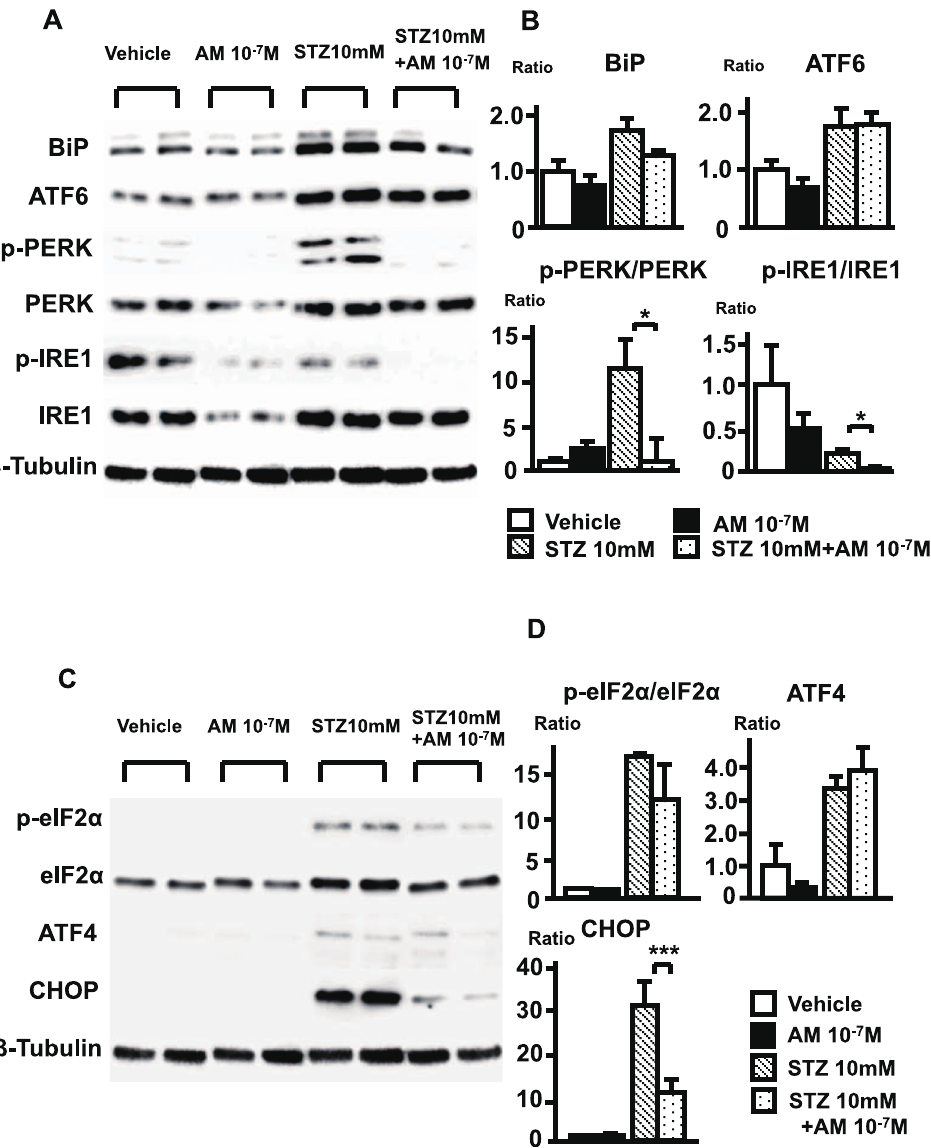
Figure 6. Western blot analysis of ER stress-related factors in STZ-treated RPTECs. (A) Western blot analysis of ER stress sensor molecules in STZ-treated RPTECs. (B) Optical densities of Western blots were quantified, and the relative expression of BiP and ATF6 and the p-PERK/PERK and p- IRE1/IRE1 ratios (PERK and IRE1 activation level) are shown. (C) Western blot analysis of the mediators downstream of PERK. (D) Quantification of the results in (C). The experiments were repeated 3 times. Data from the vehicle group were assigned a value of 1. Bars are means 6 SEM. *p , 0.05, ***p , 0.001.